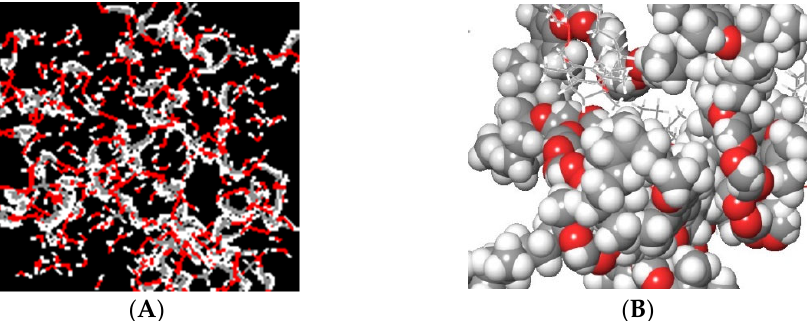
Figure 13. Polymeric structures of PEG ( A ) and TPGS ( B ). ( B ) shows the spherical 3D representation of the TPGS unit.